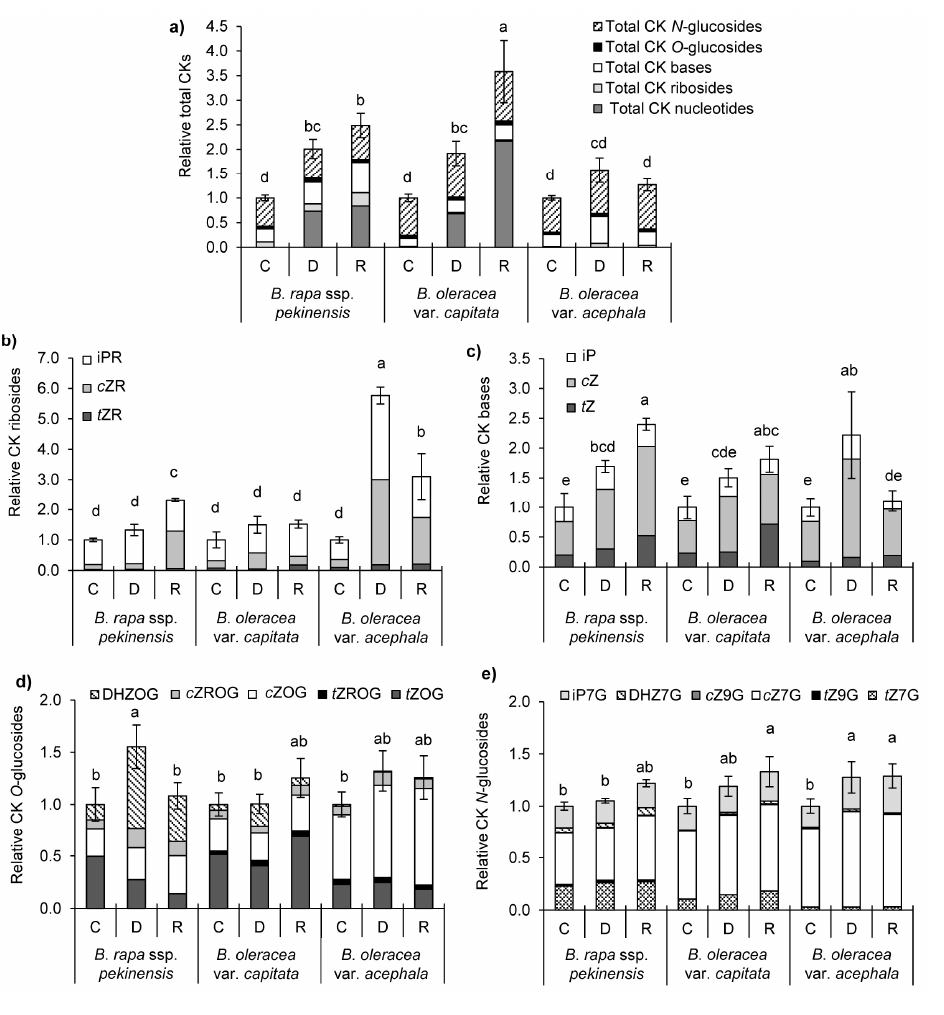
Figure 8. Cytokinins profile in Brassica crops ( B. rap a, B. oleracea var. capitata , and B. oleracea var. acephala ) under drought ( D ) and recovery ( R ) in comparison to the corresponding controls ( C ); ( a ) Fluctuation of total cytokinins and distribution of individual CKs groups (nucleotides, ribosides, bases, O -glucosides, and N -glucosides); data are mean of 4 replicates; error bars present SD of total CKs. Fluctuations of CKs groups and individual types of CKs among group: ( b ) ribosides (R), ( c ), active bases ( trans- zeatin, t Z; cis- zeatin, c Z; dihydrozeatin, DHZ; isopentenyladenine, iP), ( d ) O -glucosides (OG), and ( e ) N -glucosides (7G and 9G). Controls are normalized to the value 1. Columns marked with different letters are statistically significantly different ( p ≤ 0.05). Data are means of 4 replicates; error bars present SD of total CKs groups. Raw data, normalized data and statistical analysis of individual CKs are given in Supplementary Tables